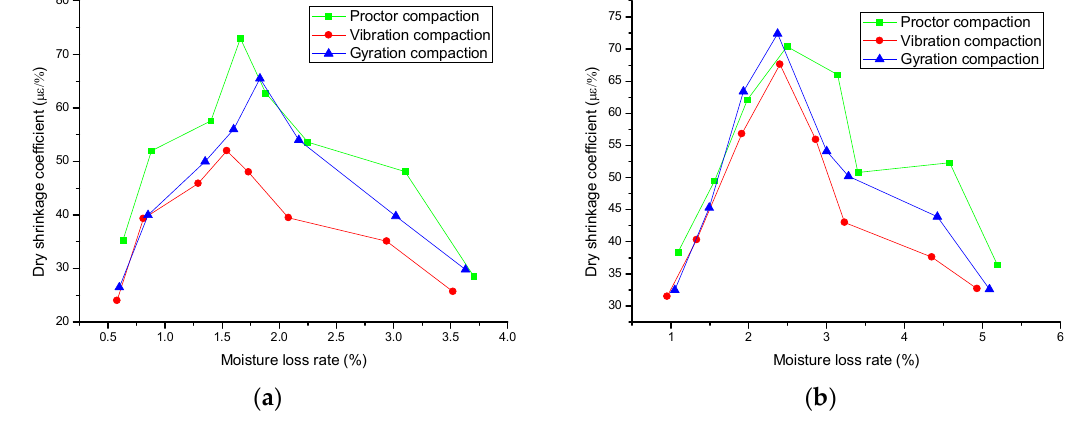
Figure 13. Dry shrinkage coefficients of ( a ) Aggregate A and ( b ) Aggregate B.